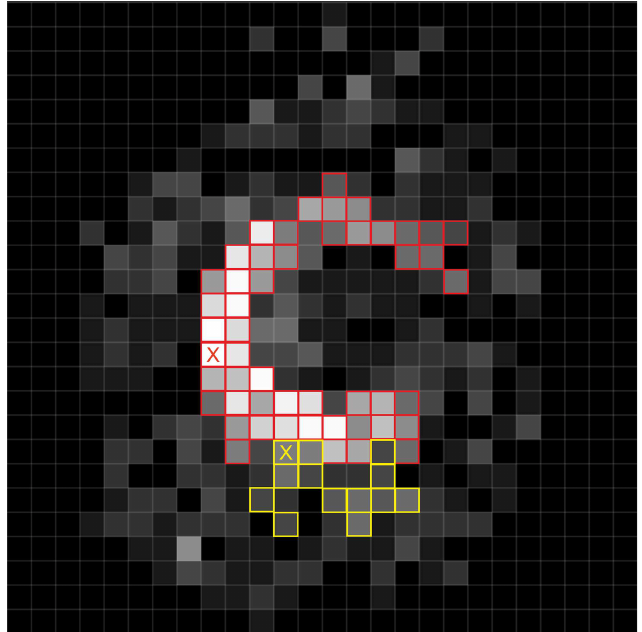
Figure 6. Example of the region growing method used in this study. Two groups are generated. The “X” denotes the starting seeds for each